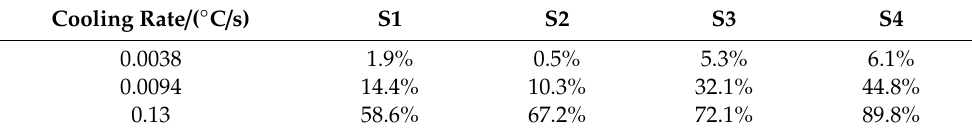
Table 4. Bainite volume fraction of experimental steels at different cooling rate. Cooling Rate / ( ◦ C / s) S1